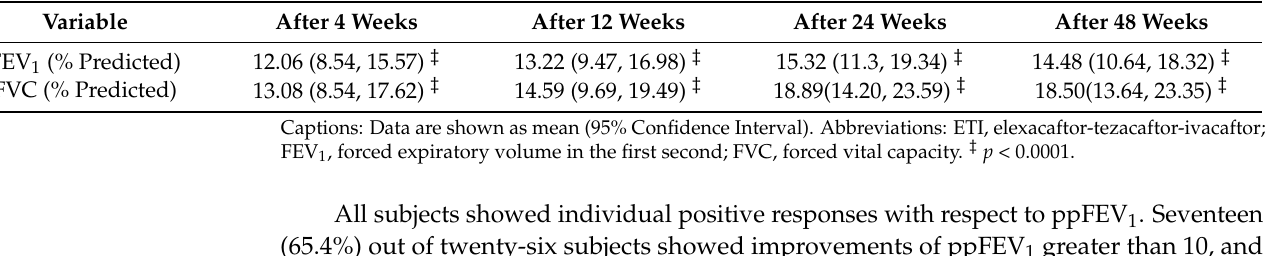
Table 2. Absolute change of lung function after treatment with ETI over the 48-week